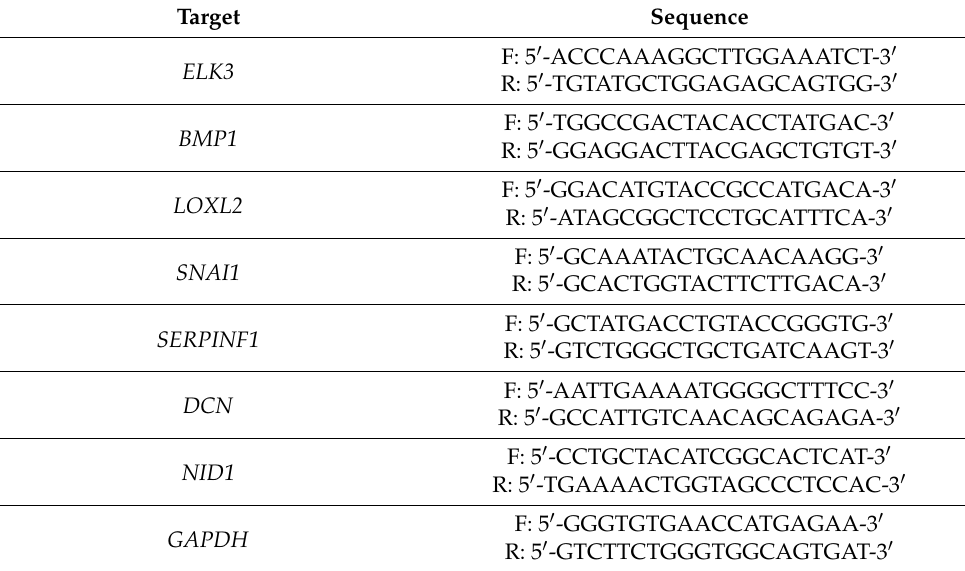
Table 1. The primer sets for